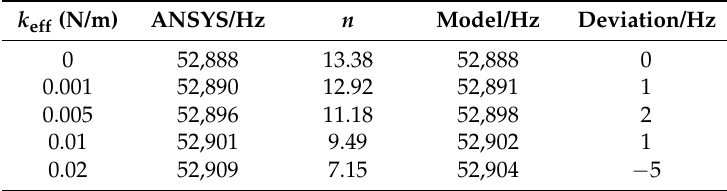
Table 4. The results of ANSYS simulation with different values of k eff .